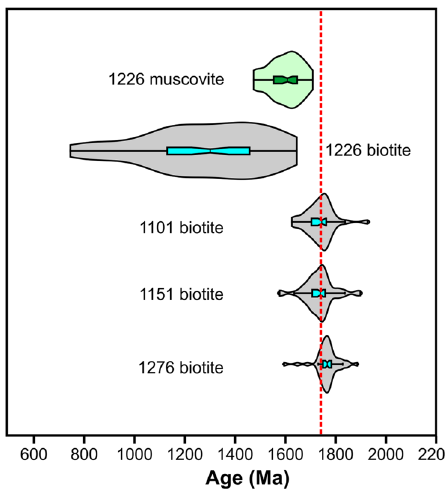
Fig. 9 Measures of central tendency and variability in Rb – Sr ages from Akia Terrane mica grains. Violin plots with box and whisker overlay of biotite and muscovite Rb – Sr model ages. Median values are denoted by the central black line in the box, Q1 and Q3 by the bars. Red vertical bar denotes mode at c. 1750 Ma. Muscovite is indicated by the green fi ll in the violin plot of sample 1226.